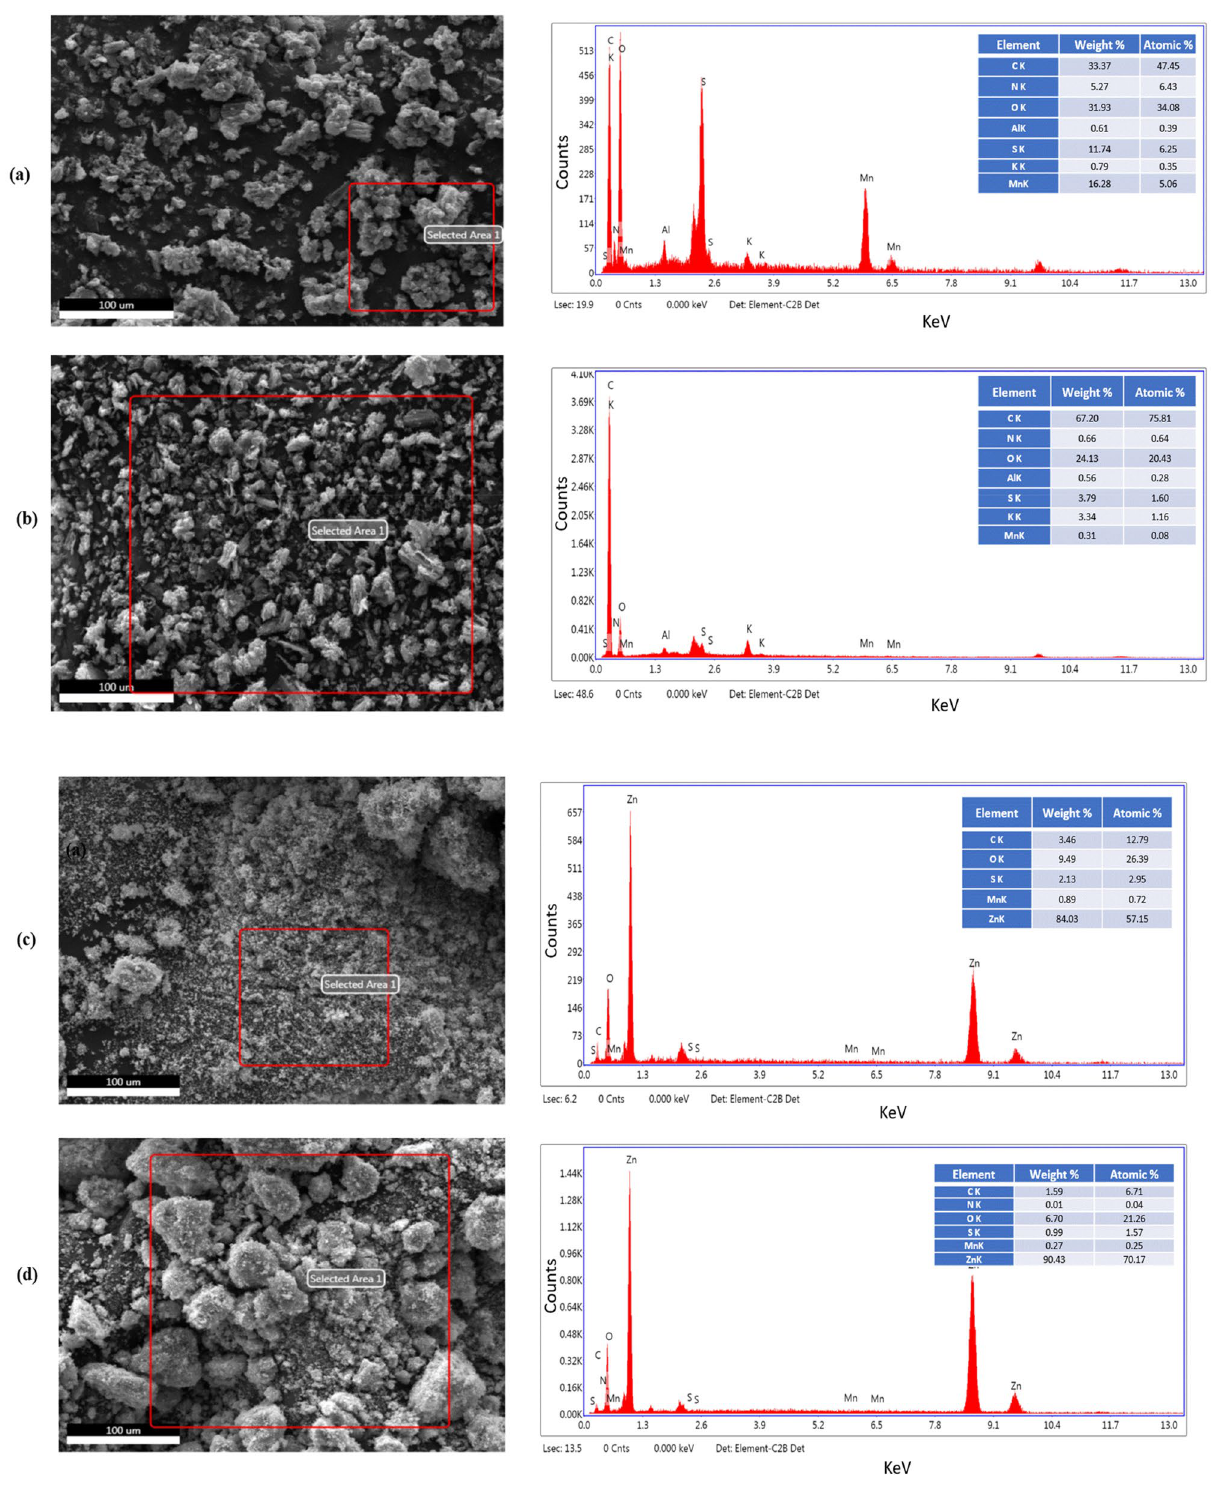
Figure 2. Scanning electron microscopy with energy-dispersive X-ray spectroscopy (SEM–EDX) analysis ( a ) GO, ( b ) RGO, ( c ) GO-ZnO, and ( d )